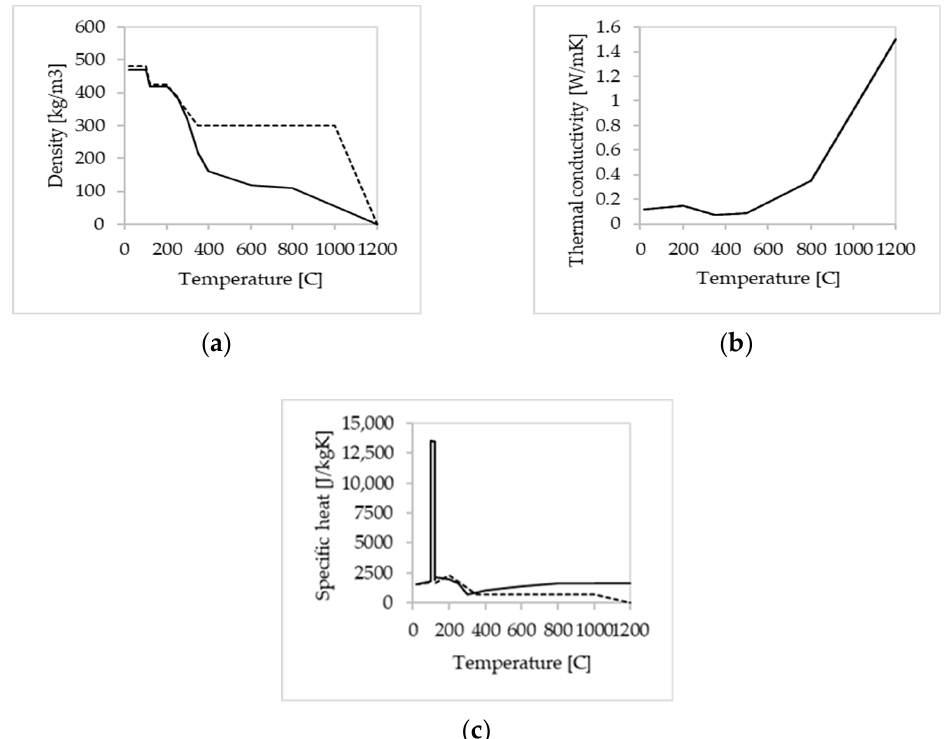
Figure 5. Thermal proprieties of wood used for the heat transfer model: ( a ) Temperature–density relationship based on glulam specimen; ( b ) Temperature–thermal conductivity relationship for wood; ( c ) Temperature–specific heat relationship for wood. Solid line for thermal properties under a standard fire curve and dashed line for thermal properties under a constant heat flux [10,32].